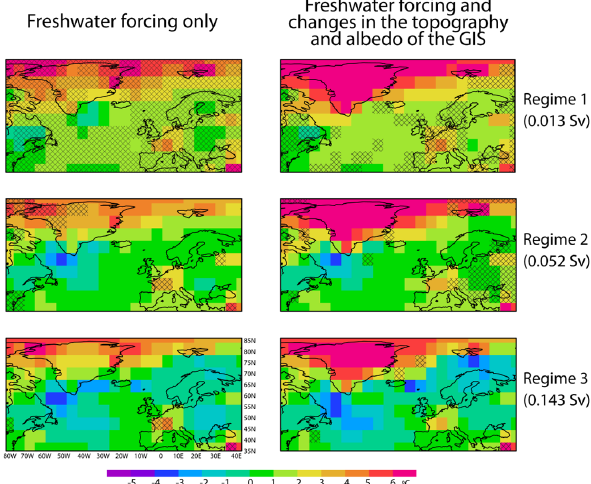
Fig. 6. Comparison of atmospheric July surface temperature anoma- lies ( ◦ C) in the North Atlantic region for the 3 regimes (top to bot- tom) compared to the PI-ctrl. Figures on the left-hand side depict simulations with only FWF and on the right-hand side with both FWF and changes in the elevation and extent of the GIS. Non- hatched areas indicate the regions for which the simulated anoma- lies are significantly different at the 5% significance level from the LIG-ctrl anomalies with respect to internal climate variability in the LIG-ctrl simulation (calculated with a t-test).